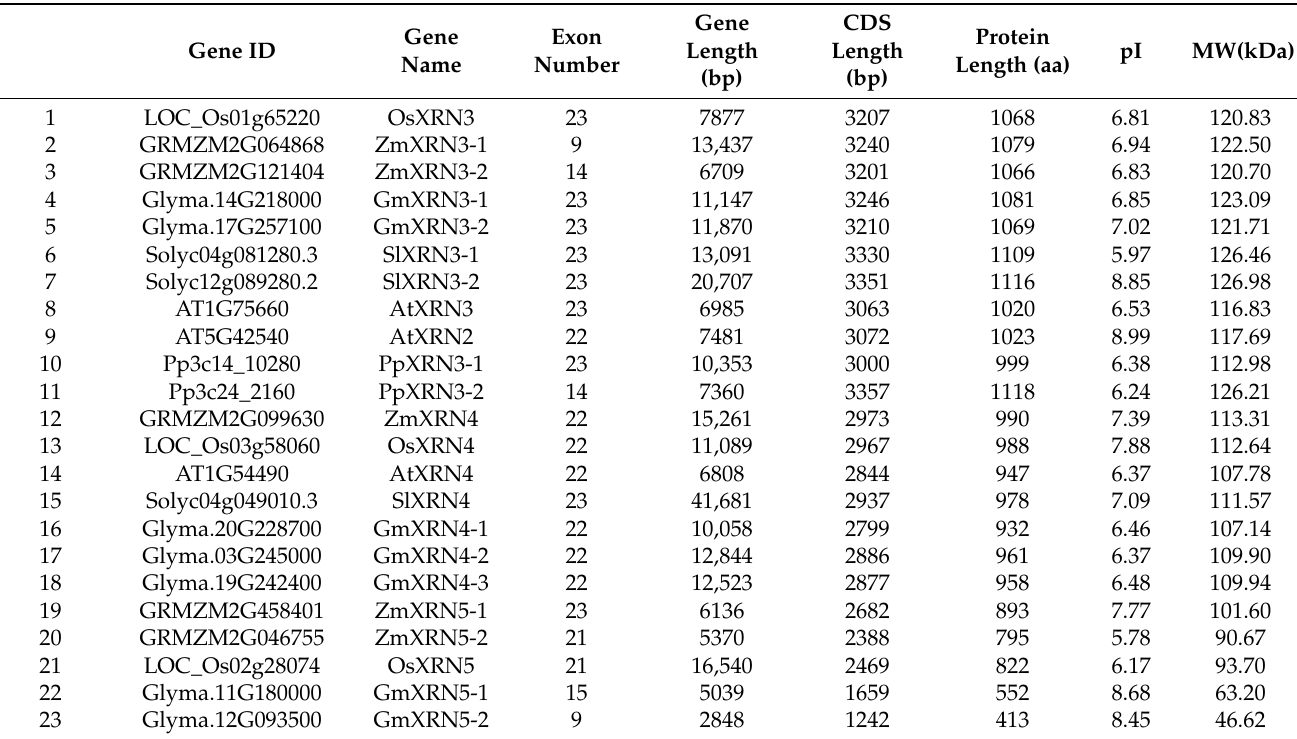
Table 1. The summary of 23 XRN proteins in 6 plant species, including their gene ID, gene name, exon number, gene length, CDS length, protein length, pI, and